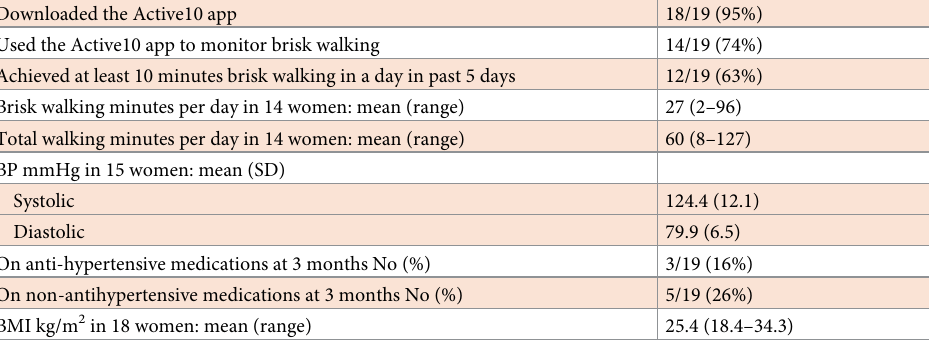
Table 2. Outcomes at three months in 19 women followed